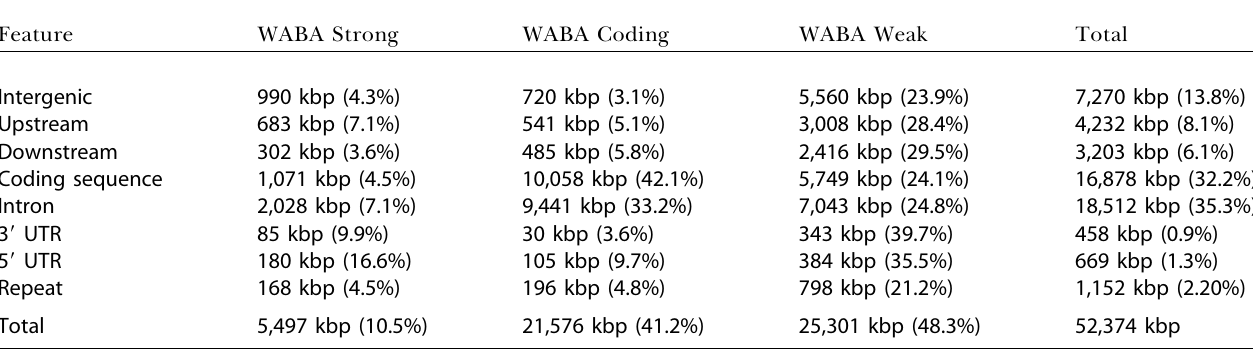
Table 8. Bases Covered by Aligned WABA Blocks, Stratified by Relationship to Annotated C. elegans Genes Feature